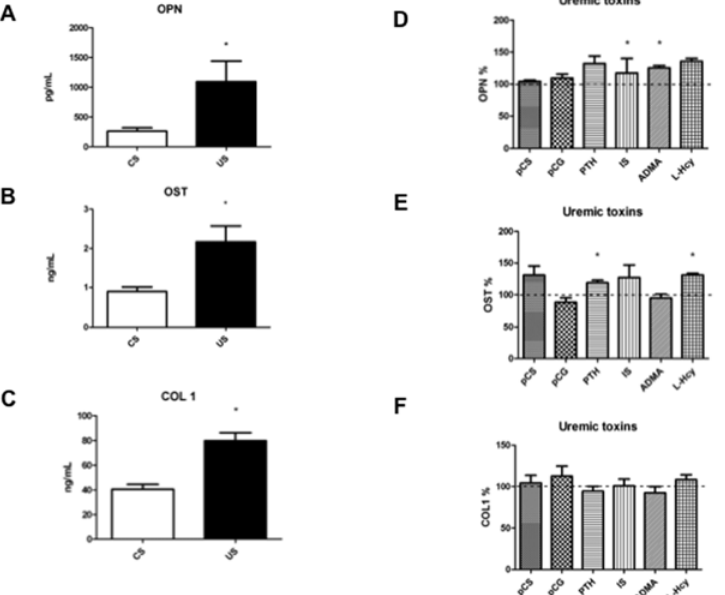
Figure 4. Levels of osteopontin, osteocalcin and collagen type I in response to serum from uremic patients, or individual uremic toxins, during osteogenic differentiation. Osteopontin (OPN, panel A), osteocalcin (OST, panel B) and collagen type I (COL1, panel C) were measured in the medium of hMSCs cultured in the presence of uremic serum (US) vs. control serum (CS). OPN (panel D), OST (panel E) and COL1 (panel F) were also monitored in parallel experiments in which hMSCs were cultured in the presence of control serum added with the indicated uremic toxins (pCS, p-cresylsulfate; pCG, p-cresylglucuronide; PTH, parathyroid hormone; IS, indoxyl sulfate; ADMA, asymmetric dimethylarginine; Hcy, homocysteine) compared to NS as such. * p < 0.05.